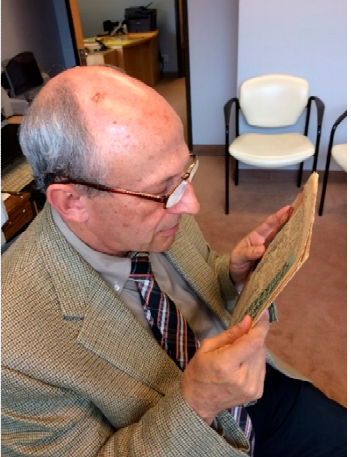
Figure 7. Child, using accommodation.